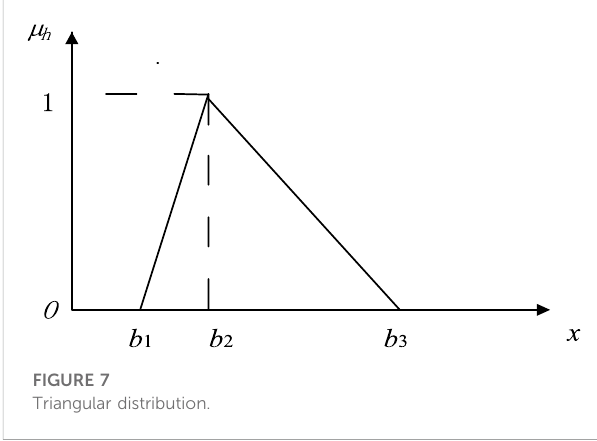
appears on the membership degree λ (cid:2) 1 curve, and the peak value of the core area appears on the membership degree k (cid:2) 2 . 0 curve, while the peak value of the right transition area appears on